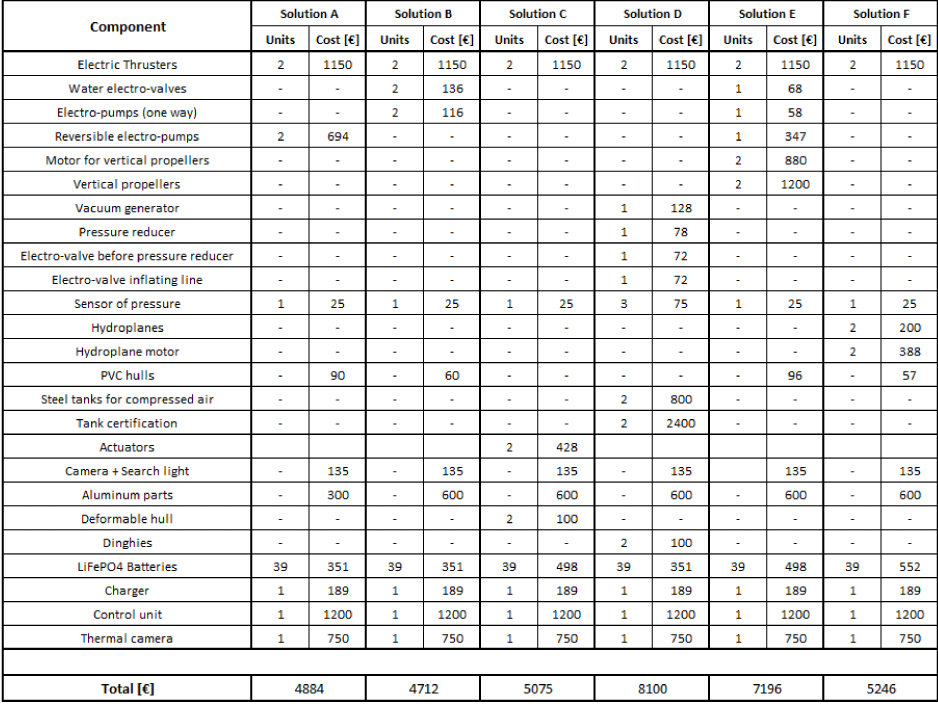
Figure 7. Cost analysis conducted on the proposed robot configurations.